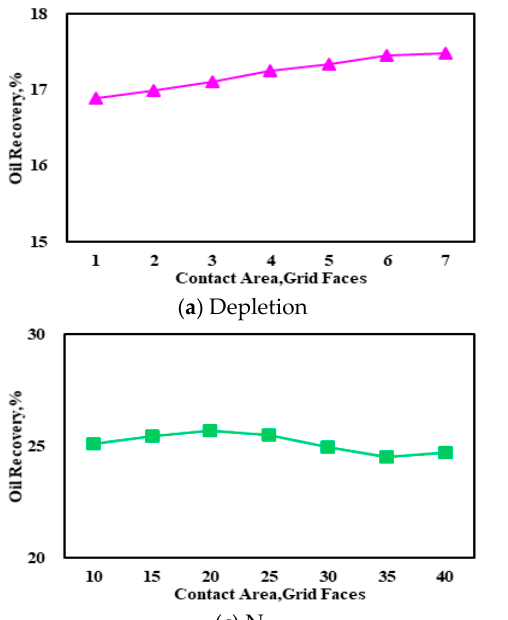
Figure 33. Relationship between contact area and oil recovery in different modes.